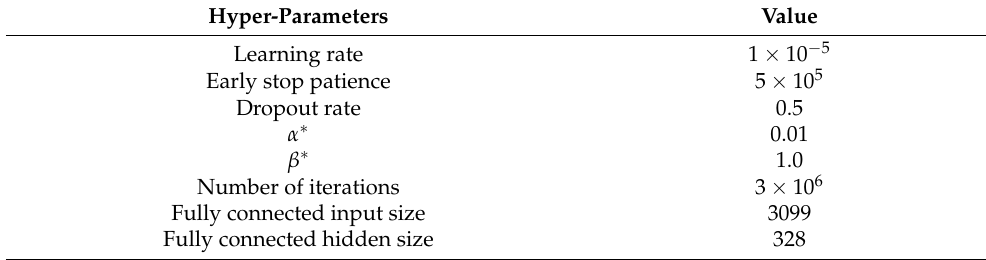
Table 2. Hyper-parameters table. The parameters marked with * indicate that they can be updated during the training process, and those listed in the table indicate their initial values at the beginning of